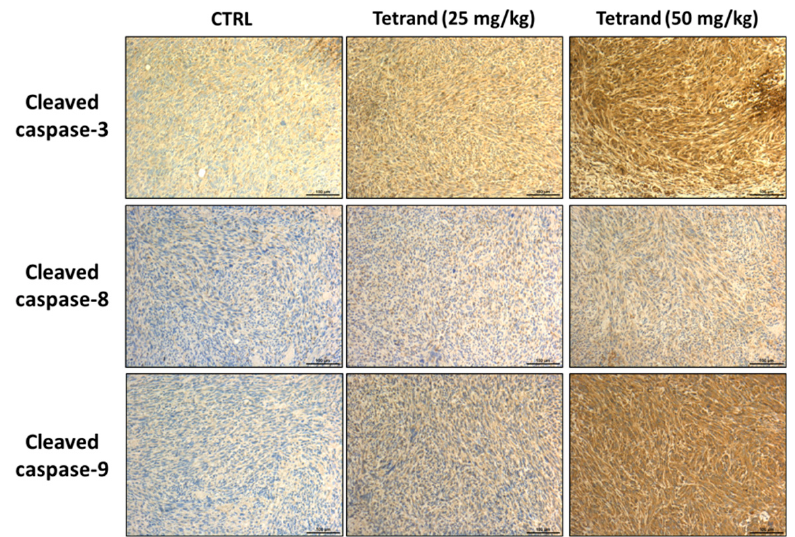
Figure 6. TET increased the expressions of pro-apoptosis-related proteins. Tumors were isolated from each group and further examined by IHC staining. The IHC staining images of cleaved caspase-3, -8, and -9 were observed under a microscope with 100 times magnification. All processes were described in Materials and Methods. Scale bar = 100 μ m.